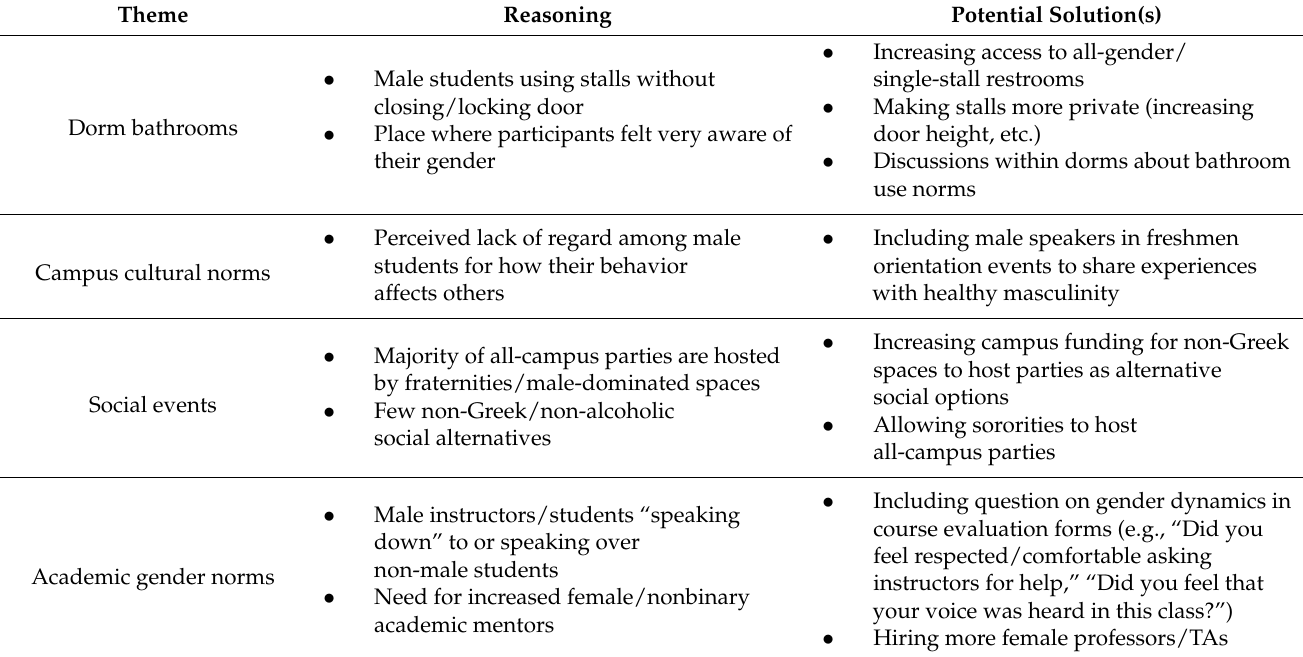
Table 2. Major themes and solutions determined by community members in pilot